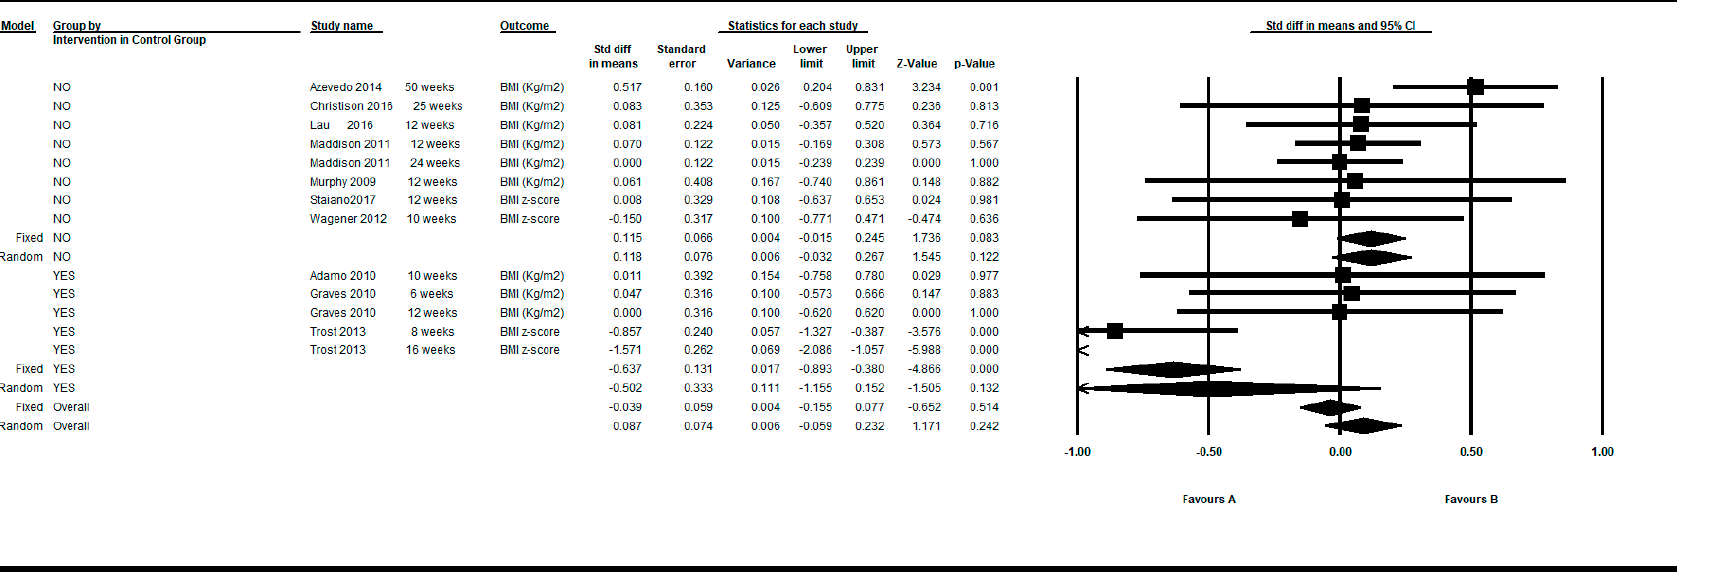
Figure 5. Pre-post intra-group difference in BMI in the control group. All measurements and all follow-ups. Table 5. Global heterogeneity in the control group, and depending on whether or not in this control group any intervention not based on active video games was practiced. All measurements and all follow-ups.